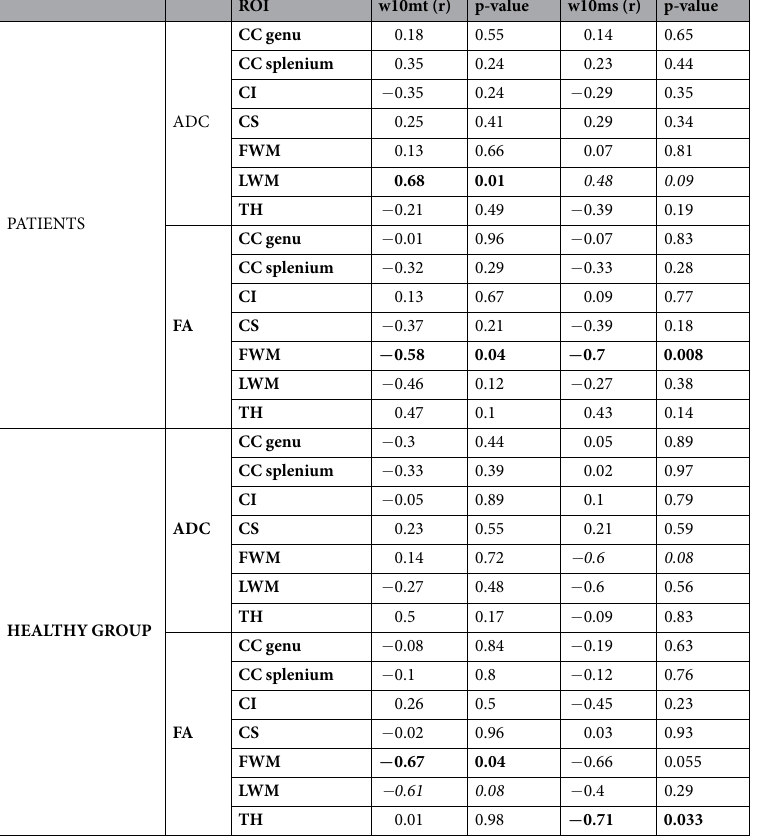
Table 5. Correlation between gait results and DTI results in patients and